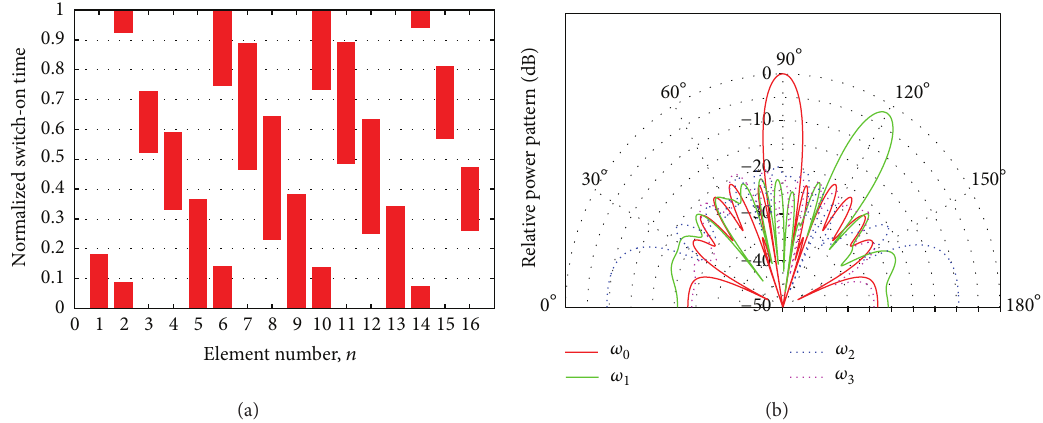
Figure 2: Single-pulse waveform, 𝑄 = 1 —multibeam sum pattern synthesis at 𝜔 0 and 𝜔 1 ( 𝑁 = 16 ; 𝑑 = 𝜆/2 ; 𝜃 𝜔 0 = 90 ∘ ; 𝜃 𝜔 1 = 120 ∘ )—plot of (a) the optimized pulse sequence and (b) corresponding power patterns generated at 𝜔 0 , 𝜔 1 , 𝜔 2 , and 𝜔 3 .